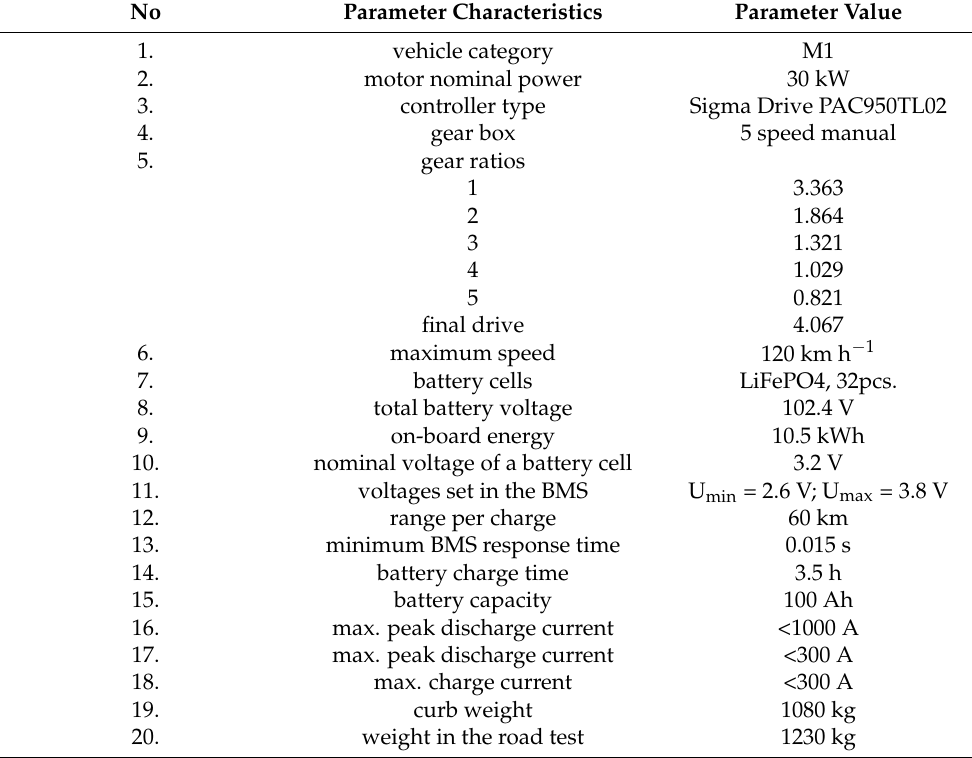
Table 1. Main technical characteristics of the converted electric car Renault Clio.